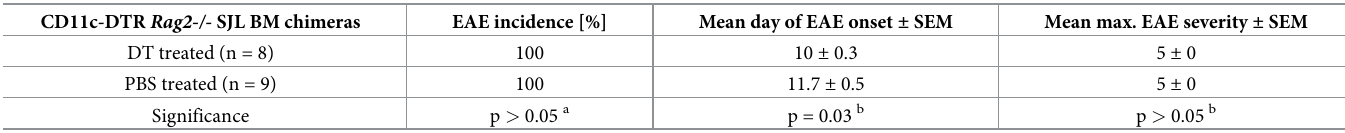
Table 3. Passive EAE in DT treated CD11c-DTR Rag2 -/- SJL BM chimeras.